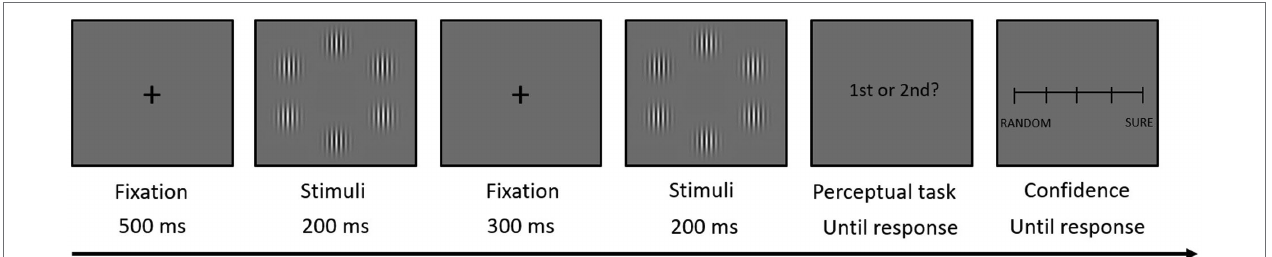
FIGURE 1 | Structure of a single trial in the perceptual confidence task. Participants viewed each stimuli array during 200 ms and had to decide which had a different contrast Gabor patch. Immediately after their response, participants had to evaluate their confidence level in their own decision on a continuous scale from ‘at random’ to ‘secure’. The task comprised 50 training and 300 experimental